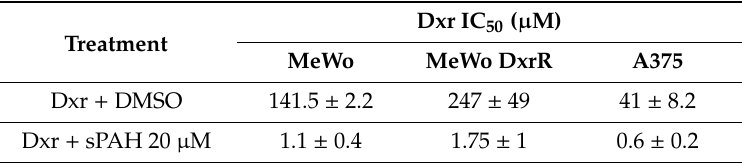
Table 1. Synthetic panicein A hydroquinone (sPAH) increases doxorubicin cytotoxicity against several melanoma cell lines. IC 50 s were calculated using GraphPad Prism 6 software. The mean ± SEM of 3 independent experiments are presented.